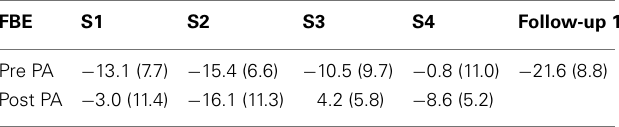
Table 2 | Bisection by pointing in far space (FBE).